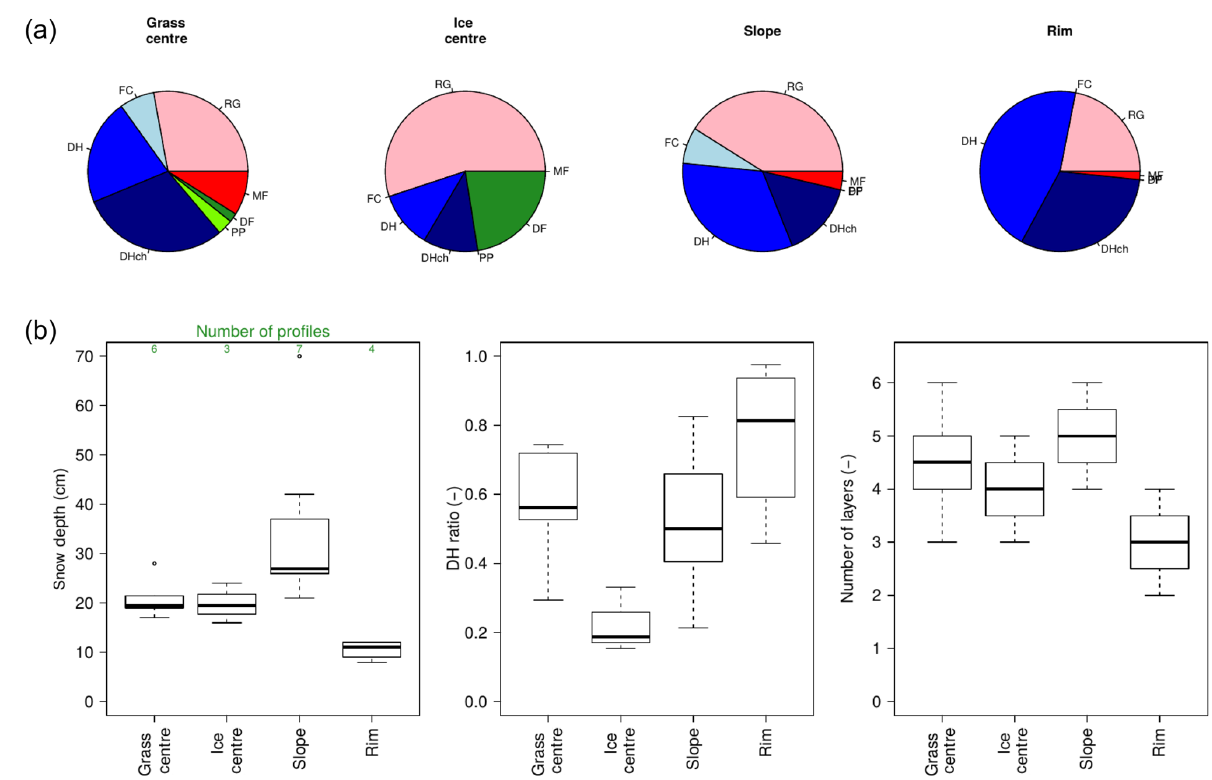
Figure 4. Mean composition (a) and median characteristics (b) of the Samoylov snowpack in the four microtopographic classes. These statistics include the observations from the 16 snow pits and the four CT sites. DH ratio is the DH thickness-to-total snow depth ratio, also called α in the paper. The abbreviations for the main grain types come from Fierz et al. (2009): PP: precipitation particles; DF: decomposing and fragmented precipitation particles; RG: rounded grains; FC: faceted crystals; DH: depth hoar; DHch: chains of DH; MF: melt forms.